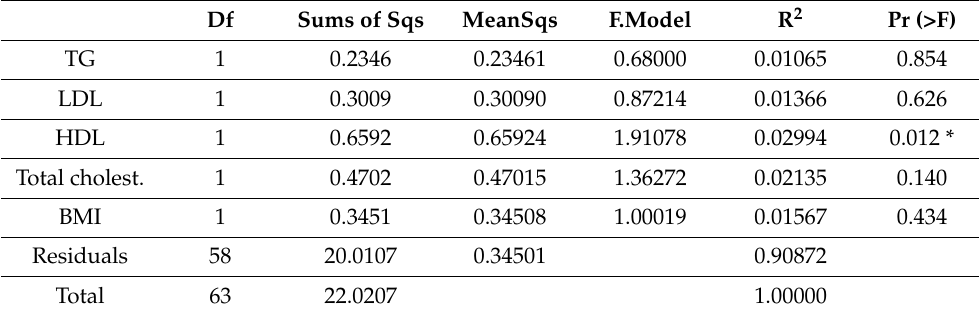
Table 2. PERMANOVA analysis to investigate the influence of different parameters on microbial community structure. Here, using beta diversity ( Bray-Curtis ) distance metrics, 29.9% (R 2 in the table given below) of the microbiome structure is explained. *, p < 0.05. Df Sums of Sqs MeanSqs F.Model R 2 Pr (>F) TG 1 0.2346 0.23461 0.68000 0.01065 0.854 LDL 1 0.3009 0.30090 0.87214 0.01366 0.626 HDL 1 0.6592 0.65924 1.91078 0.02994 0.012 * Total cholest. 1 0.4702 0.47015 1.36272 0.02135 0.140 BMI 1 0.3451 0.34508 1.00019 0.01567 0.434 Residuals 58 20.0107 0.34501 0.90872 Total 63 22.0207